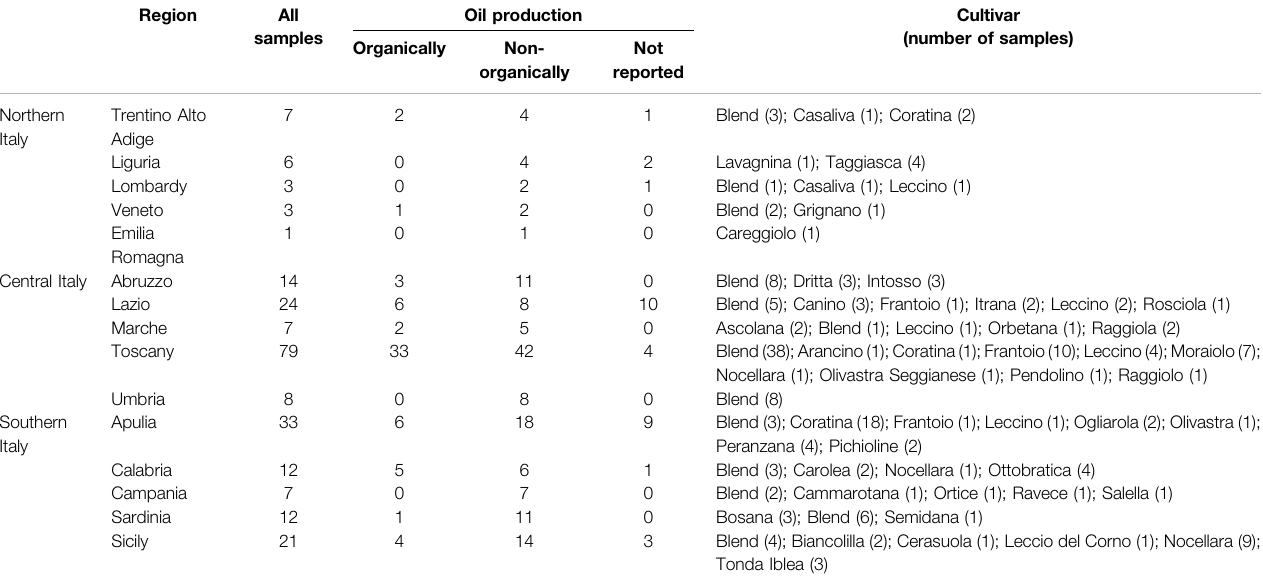
TABLE 1 | Number of samples of extra virgin olive oil for each considered category. Region All Oil samples